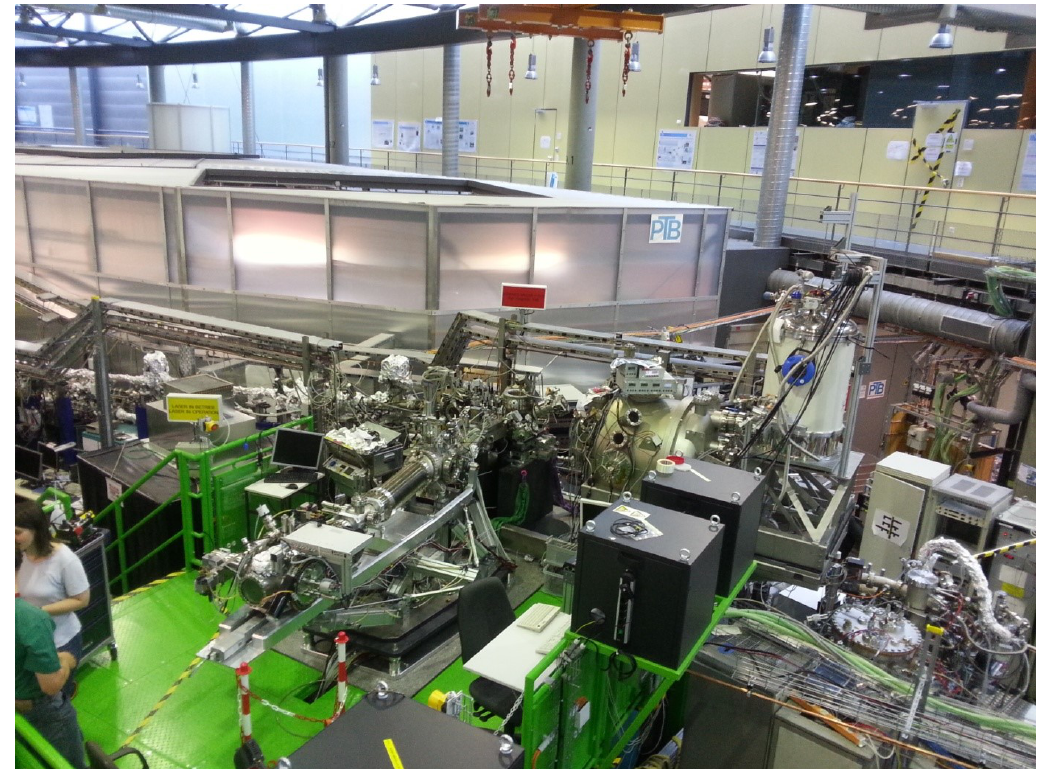
Figure 1: Top-view of beamline UE49 SGM |